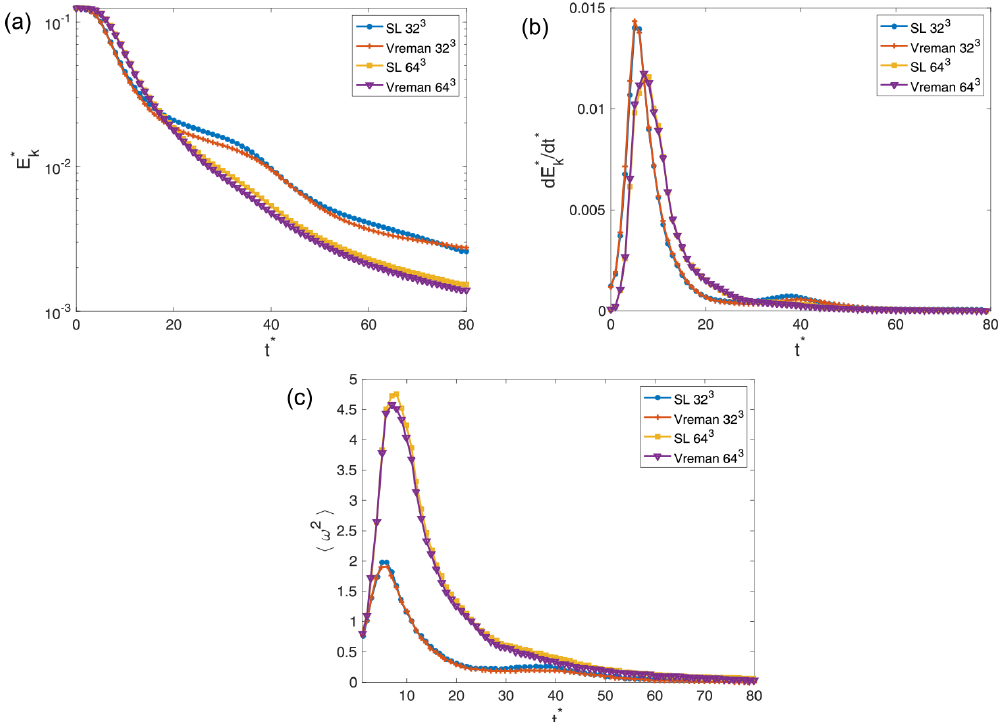
Figure 8. Evolution of volumetrically averaged (a) kinetic energy represented on a semi-logarithmic scale, (b) kinetic energy dissipation, and (c) enstrophy, each computed on 32 3 and 64 3 grids with the Vreman and SL SGS